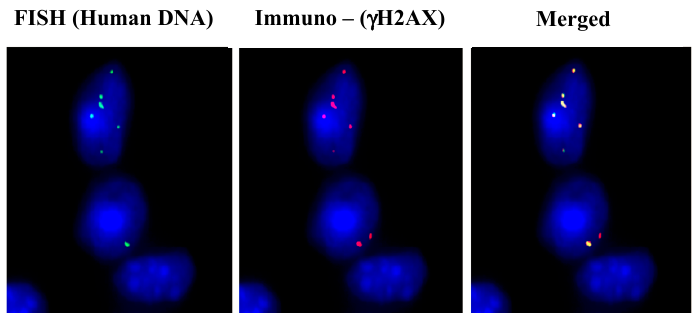
Figure 4. Genomic integration of cfCh in brain cells involves DNA double-strand break repair. Mice were injected intravenously with cfCh (100 ng DNA) isolated from cancer patients and sacrificed 24 h later. Sections of brain were processed for immuno-FISH using a human-specific whole genomic probe (green) and antibody against γ -H2AX (red). Co-localization of green and red signals are clearly visible. Magnification x60. Reproduced from [64].